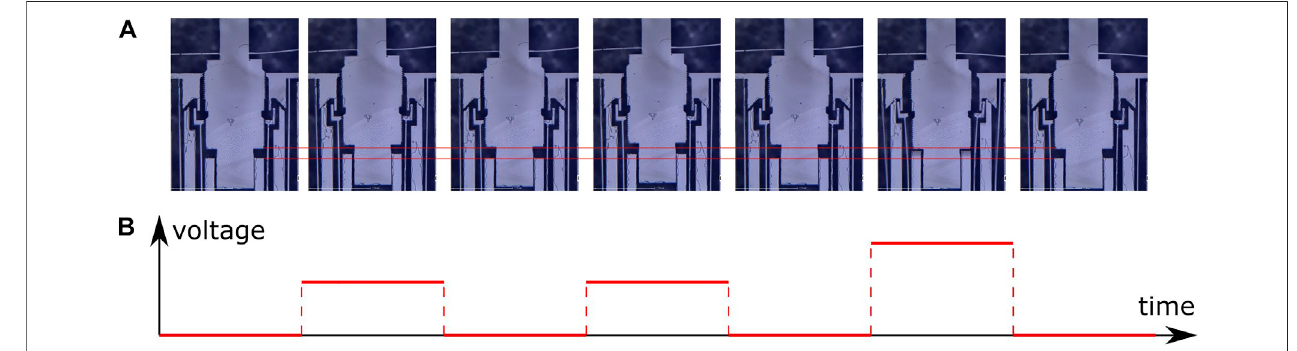
FIGURE 8 | Optical images for the (A) operation of the multistable system at (B) different voltage levels. The images show two switching steps up when the fi rst voltage level is applied, followed by a switching step down when the second voltage level is applied.